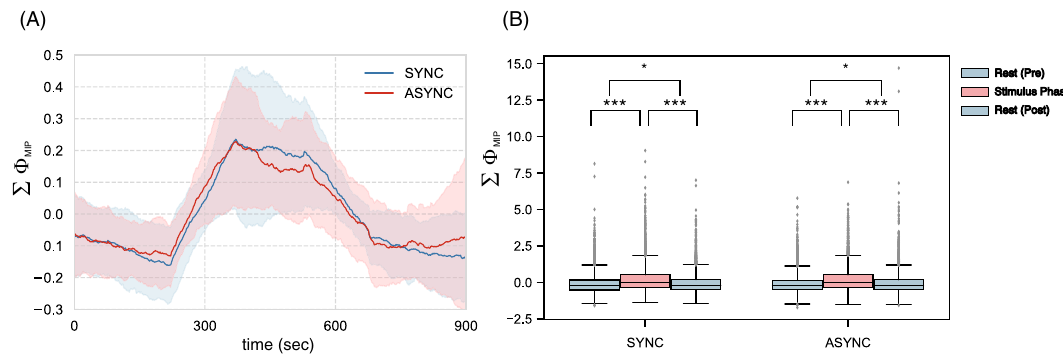
M Figure 3. ( A ) Time series of mean (cid:31) M ∈ M (cid:31) MIP in both conditions (blue: SYNC, red: ASYNC). The stimulus phase is 300 − 600 s. The other regions are in resting phase (no stimulus). The computational time frame